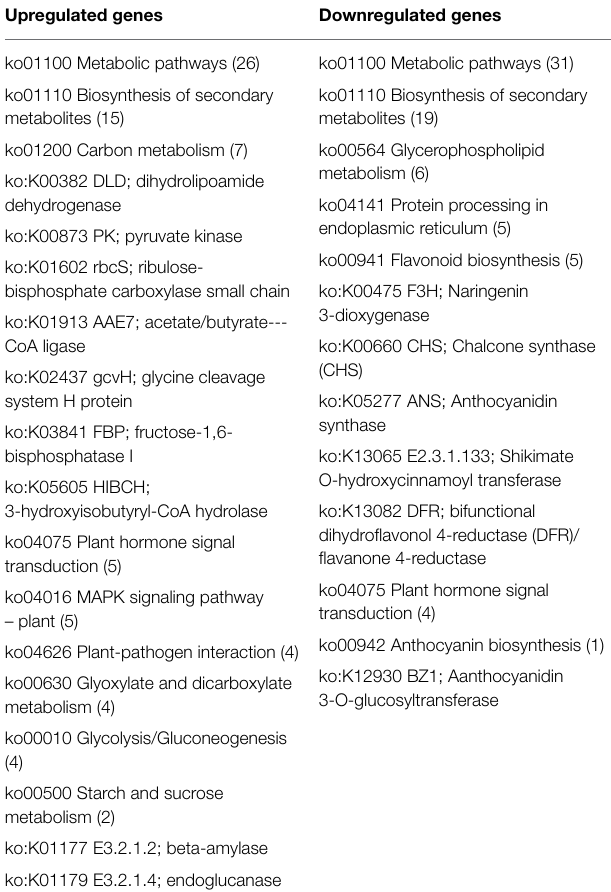
TABLE 1 | Kyoto Encyclopedia of Genes and Genomes (KEGG) pathway enrichment analysis of common upregulated and downregulated genes in two SmbHLH1 transgenic eggplant stem peels lines vs.